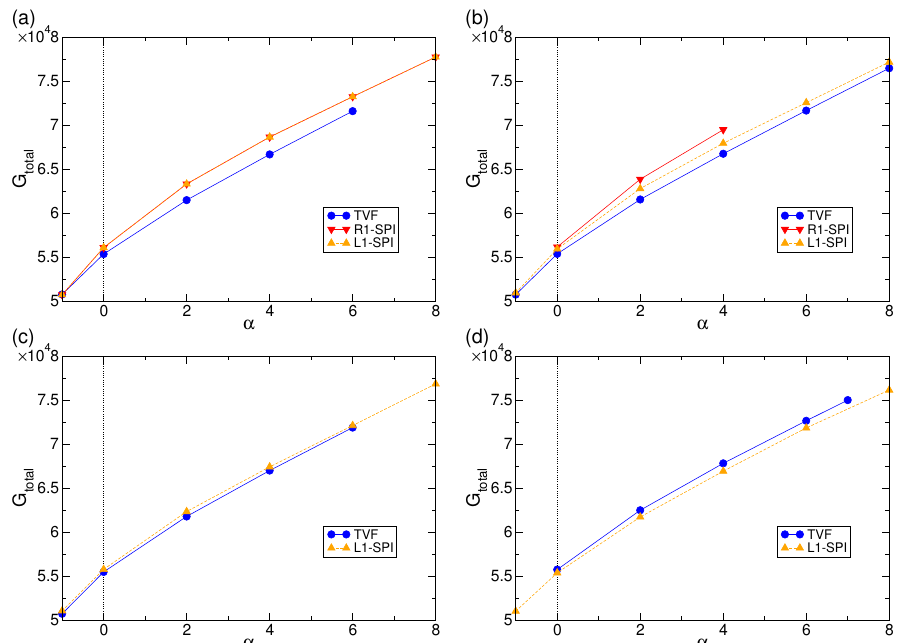
Figure 14. Dependence of the total torque G total with variation of α for different flow states at ( a ) Re = 0, ( b ) Re = 5, ( c ) Re = 10, and ( d ) Re = 20 (cf. Figure